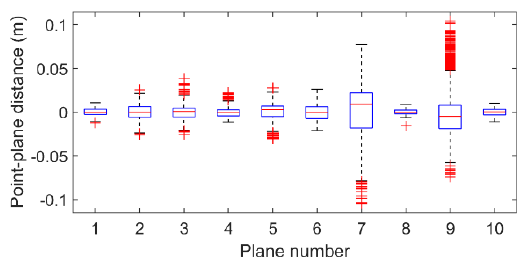
Figure 5. Distribution of signed point-plane distances for 10 planes extracted from the Hololens